Question: What form of chart is displayed?
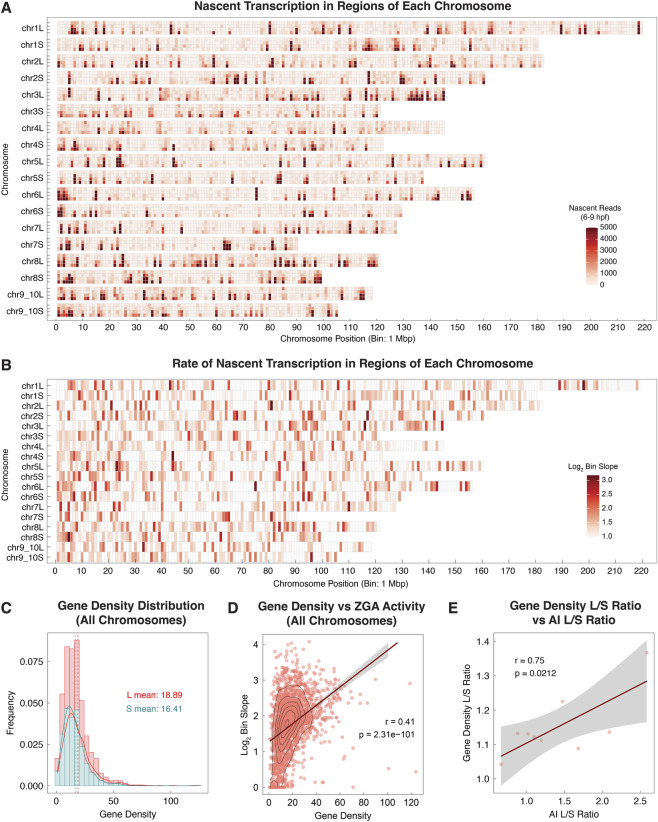
Answer: heatmap